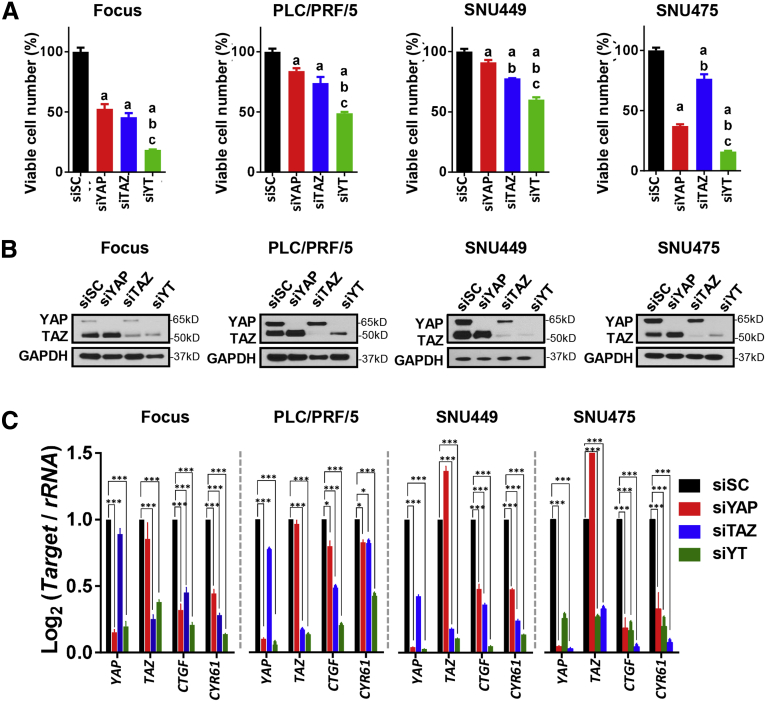
YAP and TAZ coordinately regulate HCC cell proliferation in vitro. (A) Focus, PLC/PRF/5, SNU 449, and SNU 475 human HCC cell lines were transfected with siSC, siYAP, siTAZ, and siYAP, and siTAZ (siYT) for 72 hours. Crystal violet assay was used to determine the number of viable cells. Data are presented as the percentage to siSC group in each HCC cell line respectively. The results show that inhibition of YAP or/and TAZ reduces cell proliferation. P < .05 (a) vs siSC, (b) vs siYAP, (c) vs siTAZ. (B) Expression of YAP and TAZ was detected by Western blot after treatment. (C) mRNA expression of YAP, TAZ, CTGF, and CYR61.